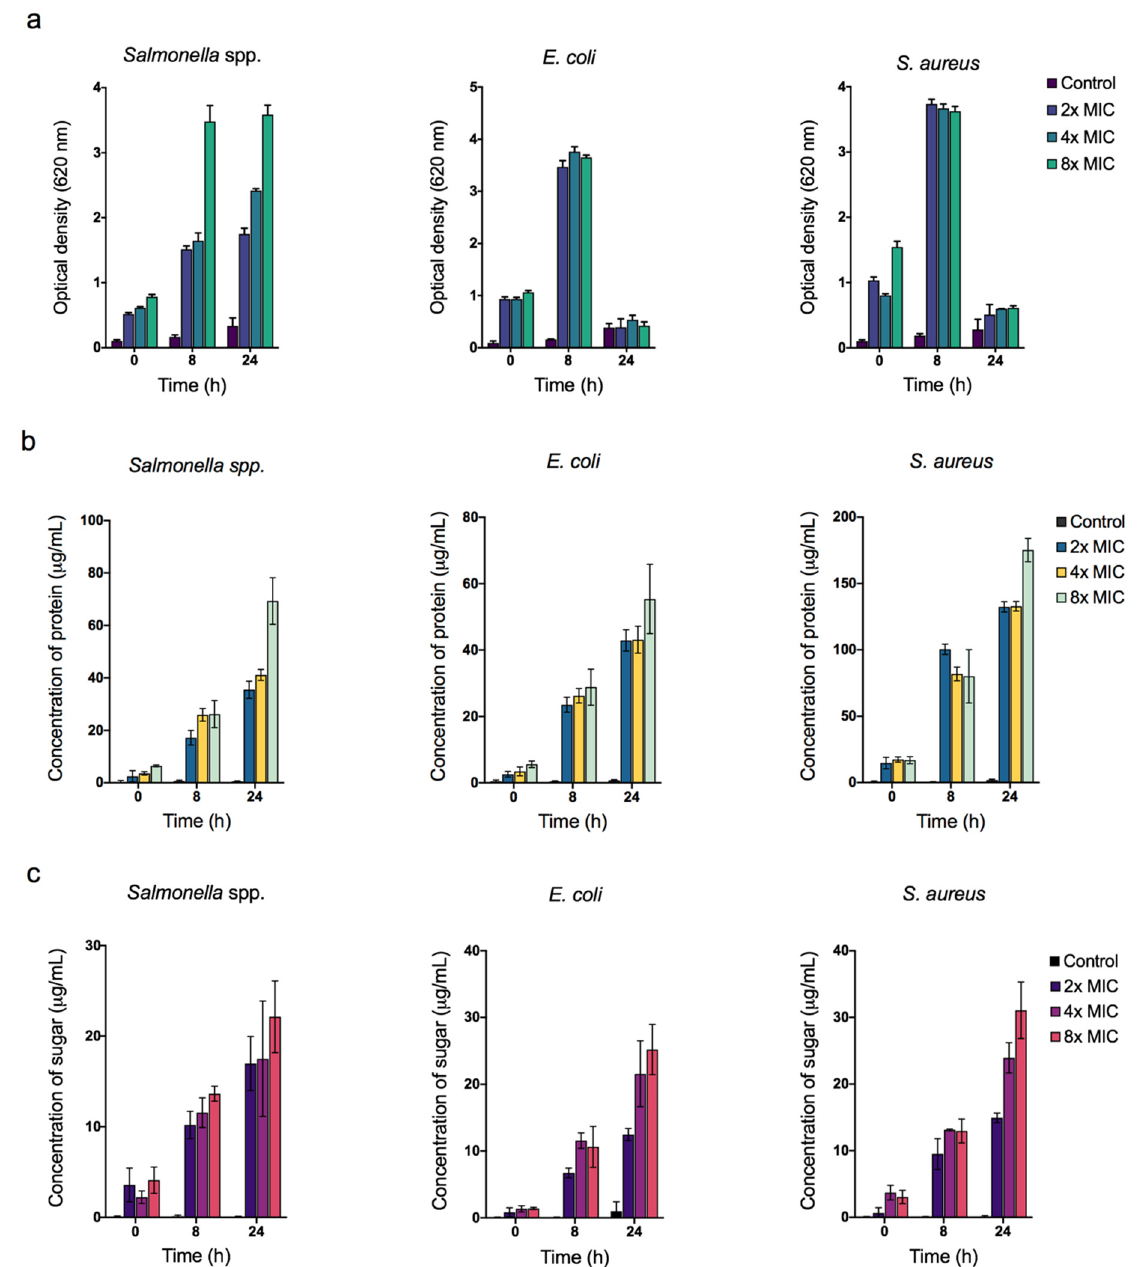
Figure 7. ( a ) Reactivity oxygen species (ROS) quantification. Cellular leakage analysis of ( b ) protein content and ( c ) reducing sugar from the cell suspensions of Salmonella spp., E. coli , and S. aureus bacteria treated with different concentrations of ZnO NPs at 0, 8, and 24 h of incubation time. Data were shown as the mean ± SD of three replicates.